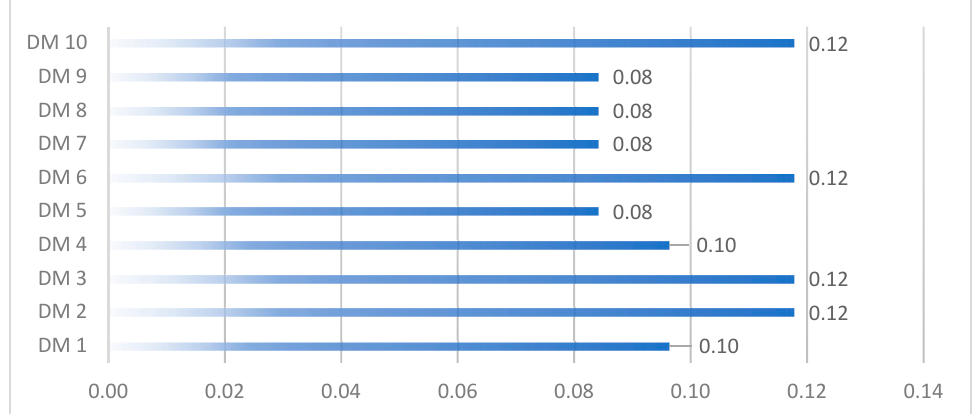
Figure 2. Smart technologies and objectives in sustainable manufacturing.